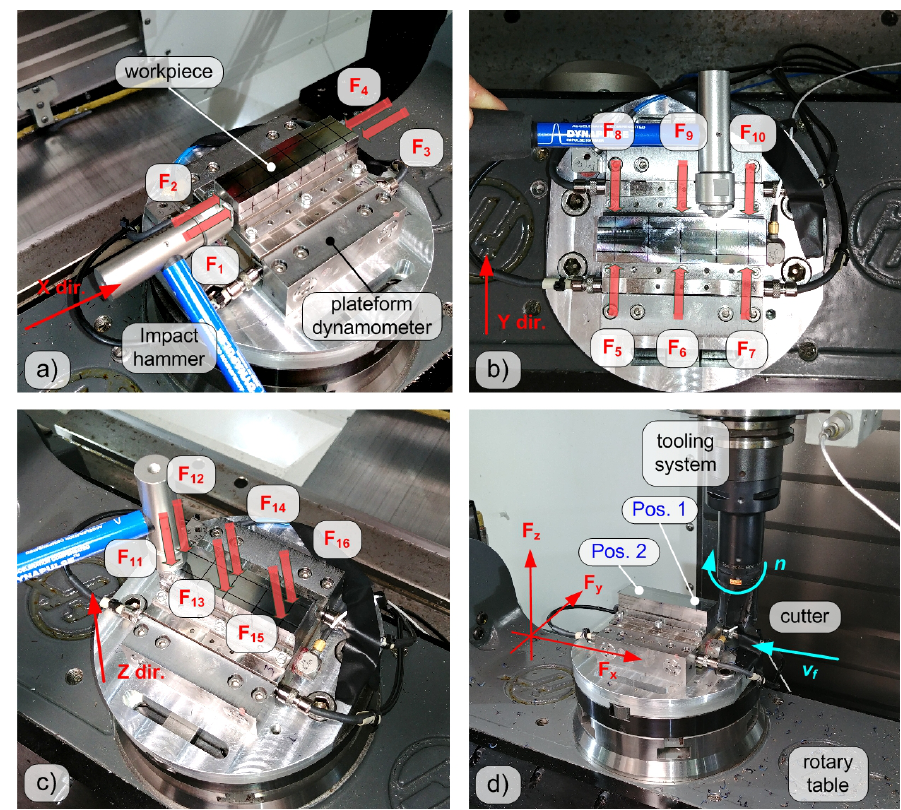
Figure 1. Impulsive forces denoted by F p with p = 1, . . . ,4 were applied at 4 different locations along the X direction ( a ). Impulsive forces denoted by F p with p = 5, . . . ,10 were applied at 6 different locations along the Y direction ( b ). Impulsive forces denoted by F p with p = 11, . . . ,16 were applied at 6 different locations along the Z direction ( c ). The experimental set-up for the final cutting tests ( d